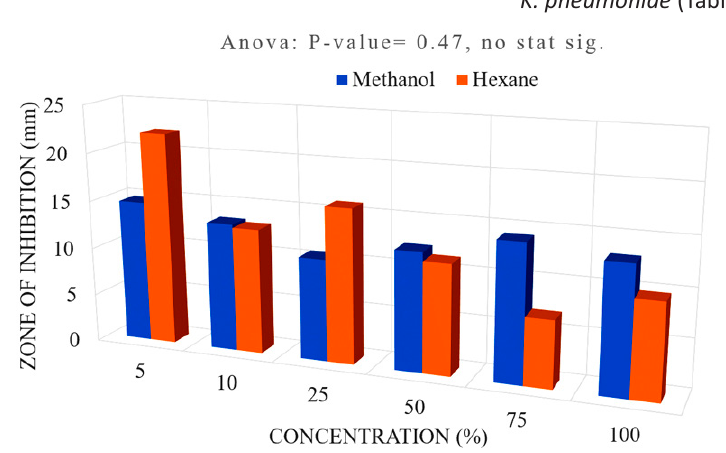
Fig. 1. Difference in zone of inhibition at different conc. for methanol and hexane extract of C.